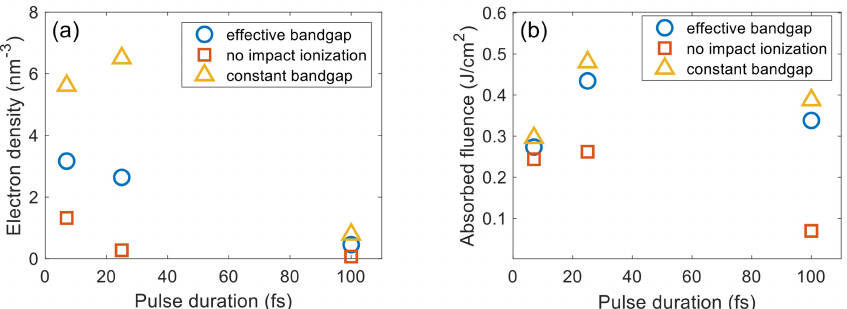
Figure 11. Comparison of ( a ) electron density and ( b ) absorbed fluence calculated from the simulation without impact ionization and the simulations with ionization but using effective and constant bandgaps. The pulse parameters are the same as those in Figure 9.